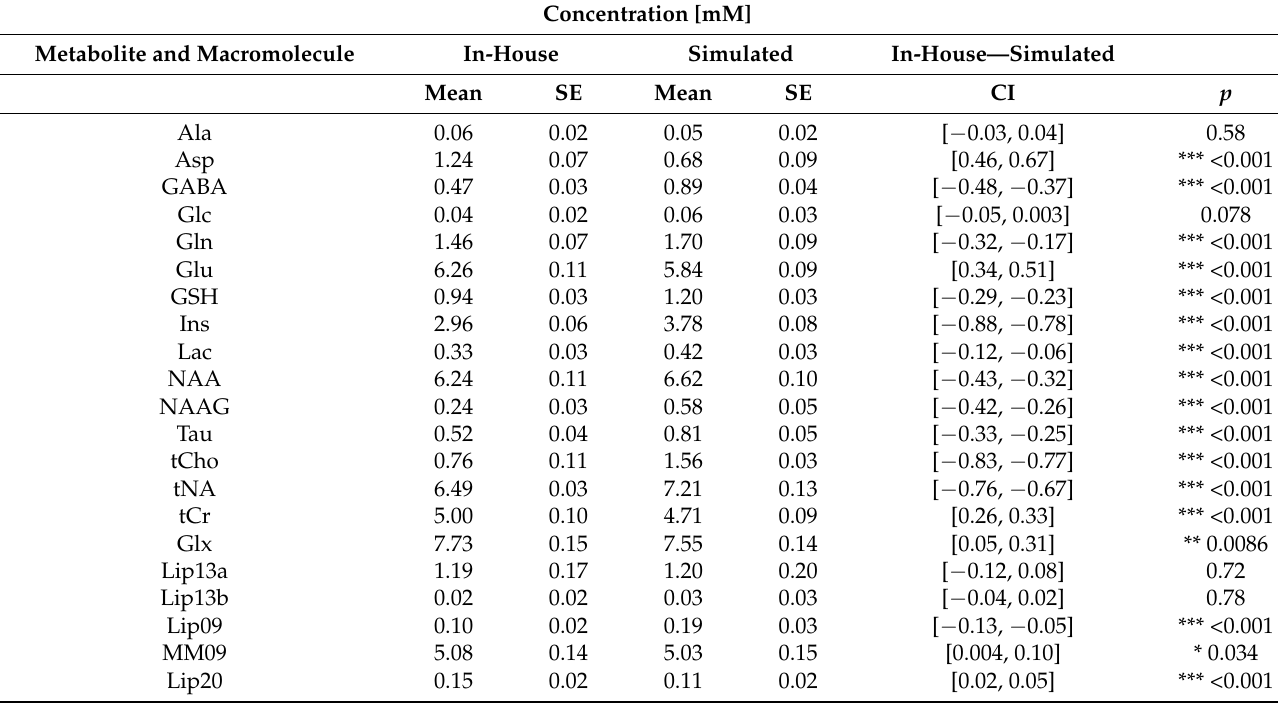
Table 2. Quantified concentrations and comparison of group difference by paired t -test. Concentration